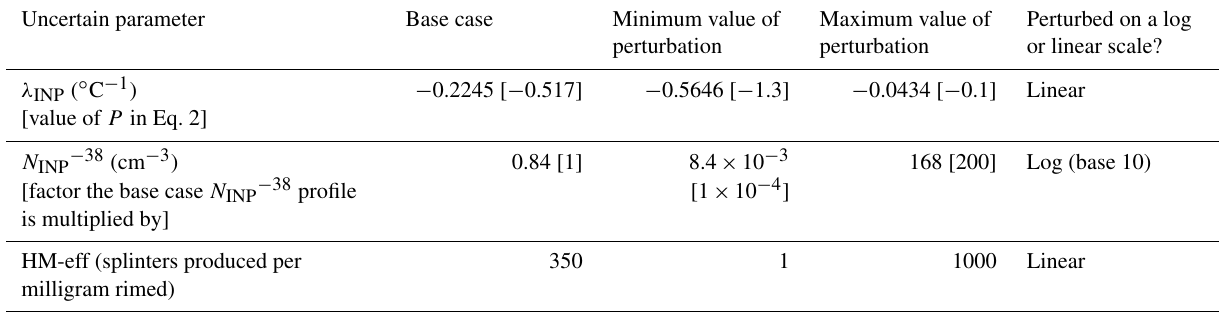
Maximum value of Perturbed on a log perturbation perturbation or linear scale?